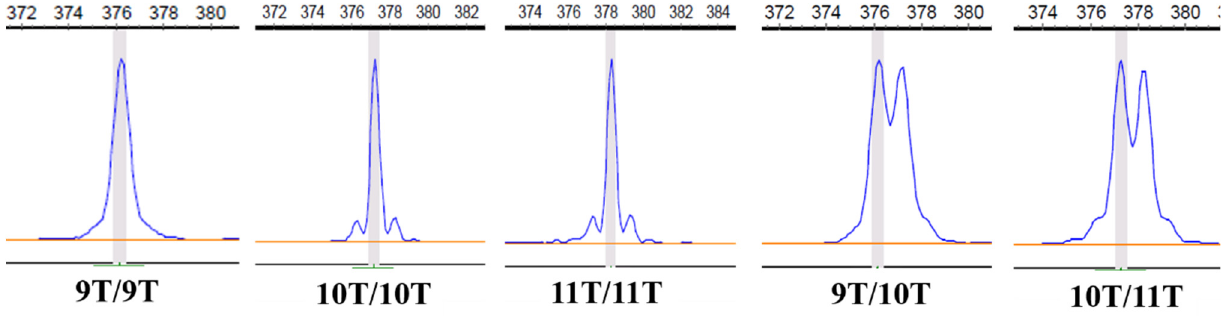
Figure 2. Fluorescence capillary electrophoresis map of genotypes for tract 2 on IGF1 polymorphisms. Table 3. Genotypic frequency of tract 2 on IGF1 gene among Chinese native pigs.